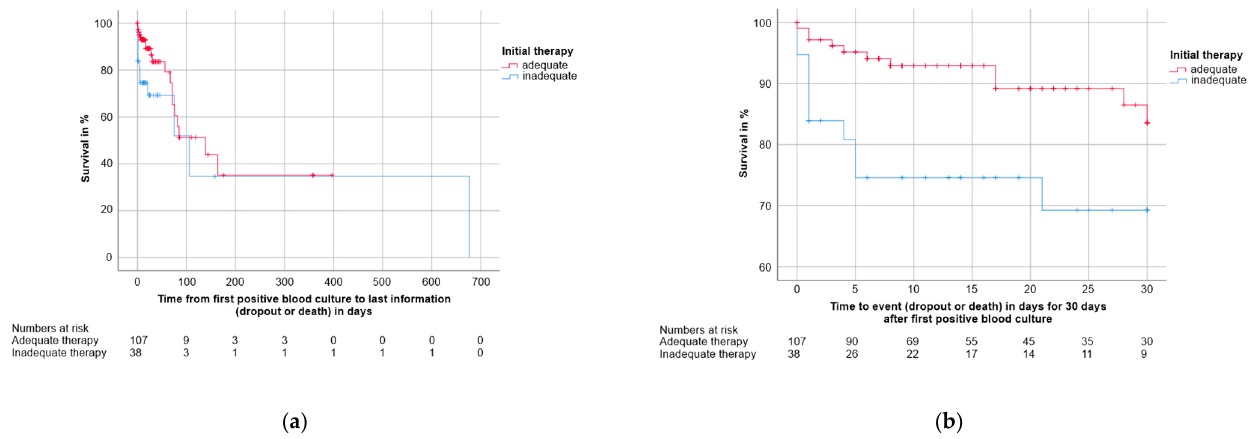
Figure 6. Kaplan-Meier survival estimates distinguished by adequacy of initial therapy. The numbers of patients under observation per therapy group at each time point are given below the figure. Data of 33 patients were missing. ( a ) Overall survival of patients with adequate ( n = 107, 20 deaths) or inadequate ( n = 38, 13 deaths) initial therapy. ( b ) 30-day survival of patients with adequate ( n = 107, 11 deaths) and inadequate ( n = 38, 10 deaths) initial therapy. Survival was worse in patients with inadequate initial therapy ( p = 0.041 for ( a ), p = 0.010 for ( b )).